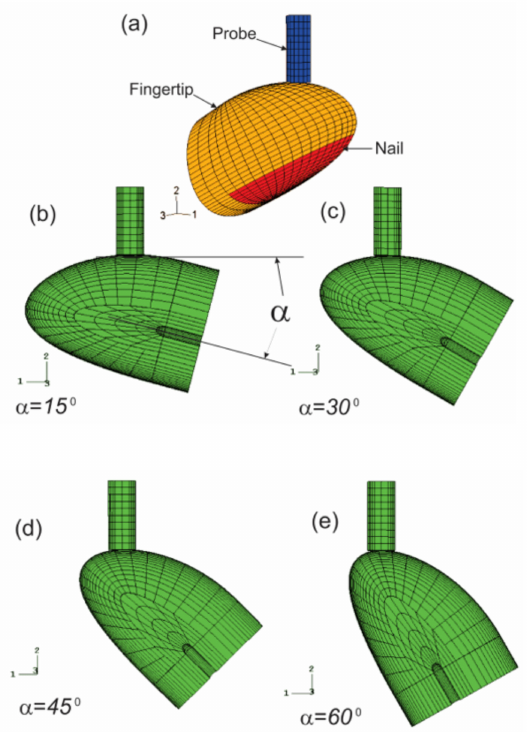
Figure 12. 3D FE modeling of the interaction between the probe and fingertip [116]: ( a ) The model; ( b – e ) The illustrations of the perspective views of the model with the fingertip is contact with the probe at angles of: ( b ) at 15 ◦ ; ( c ) at 30 ◦ ; ( d ) at 45 ◦ ; and ( e ) at 60 ◦